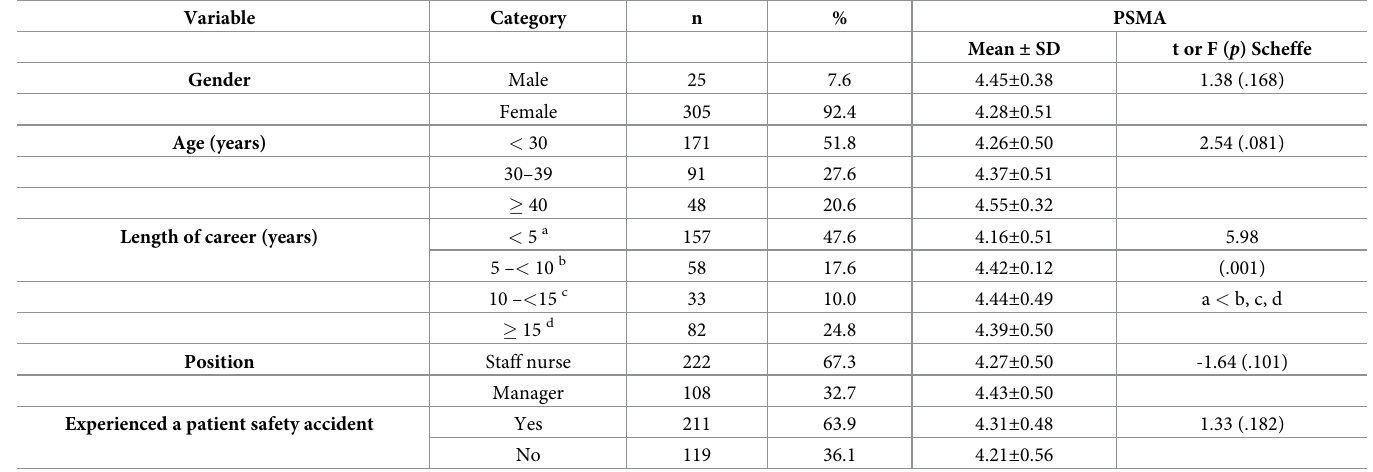
Table 1. Participants’ general characteristics (N = 330).